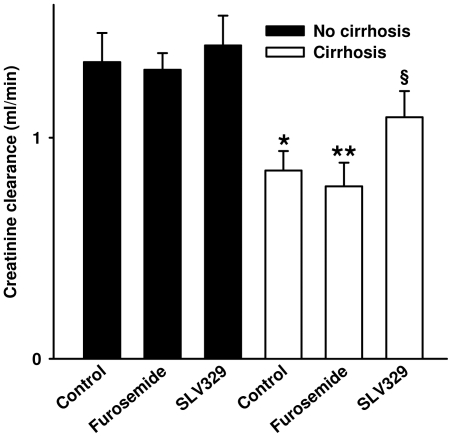
Creatinine clearance (week 16) in rats with and without liver cirrhosis.There were no significant differences between the groups in week 0 and week 8. In week 16 creatinine clearance of the cirrhotic SLV329 group was not significantly different from any of the non-cirrhotic groups. Data are means ± standard error of the mean. n = 8–10 per group (week 16). *p = 0.05, **p<0.01 vs. non-cirrhotic control rats. §p = 0.07 vs. cirrhotic animals with furosemide treatment.